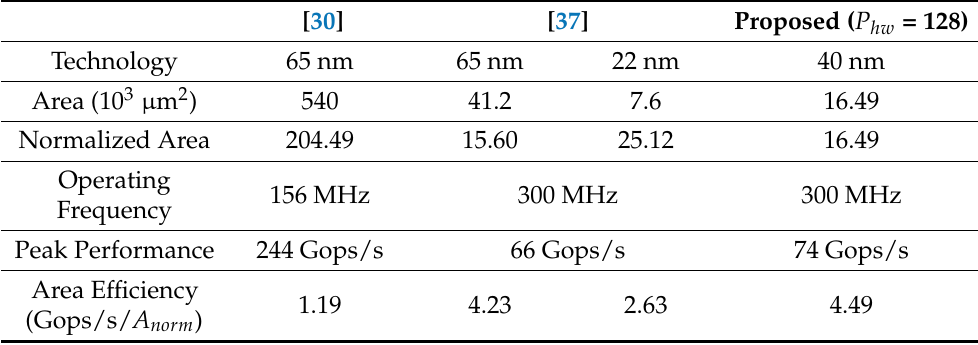
Table 4. Comparison results of the VLSI